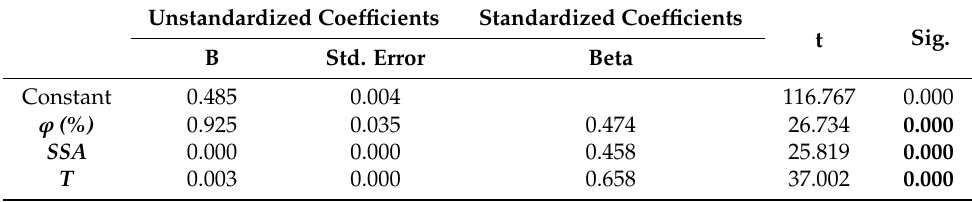
Table 7. Model parameter